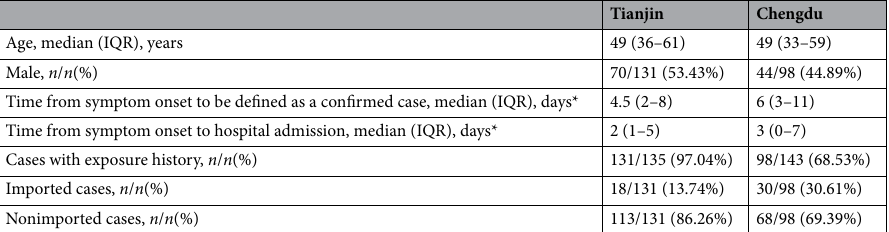
Table 1. Characteristics of COVID-19 cases in Tianjin and Chengdu. * Four noninformative cases in Tianjin had information about sex and age, while 42 of the 45 noninformative cases in Chengdu had no individual information. To keep the statistical analysis consistent, the descriptions of all variables (except exposure history) were based only on the cases with valid information about exposure history. *Of the 131 cases with an exposure history in Tianjin, 13 cases lacked information about key timelines (date of symptom onset, date of hospital admission, and date of confirmation as a case). Forty-four of 98 cases with an exposure history in Chengdu lacked information about key timelines. These cases were excluded only when the time from symptom onset to hospital admission was analyzed, as well as the time from symptom onset to confirmation as a